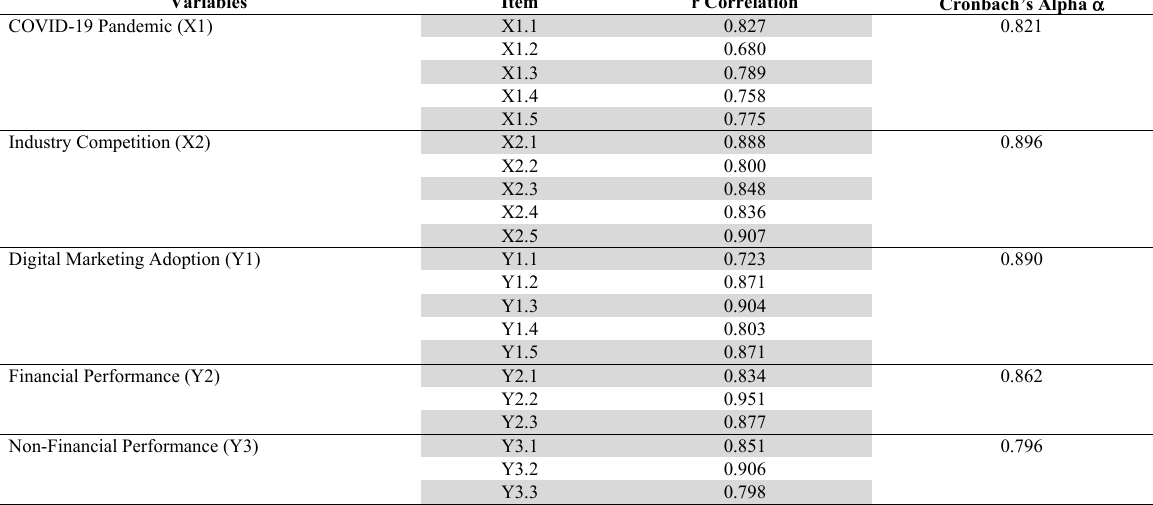
Instrument Validity and Reliability Test Results